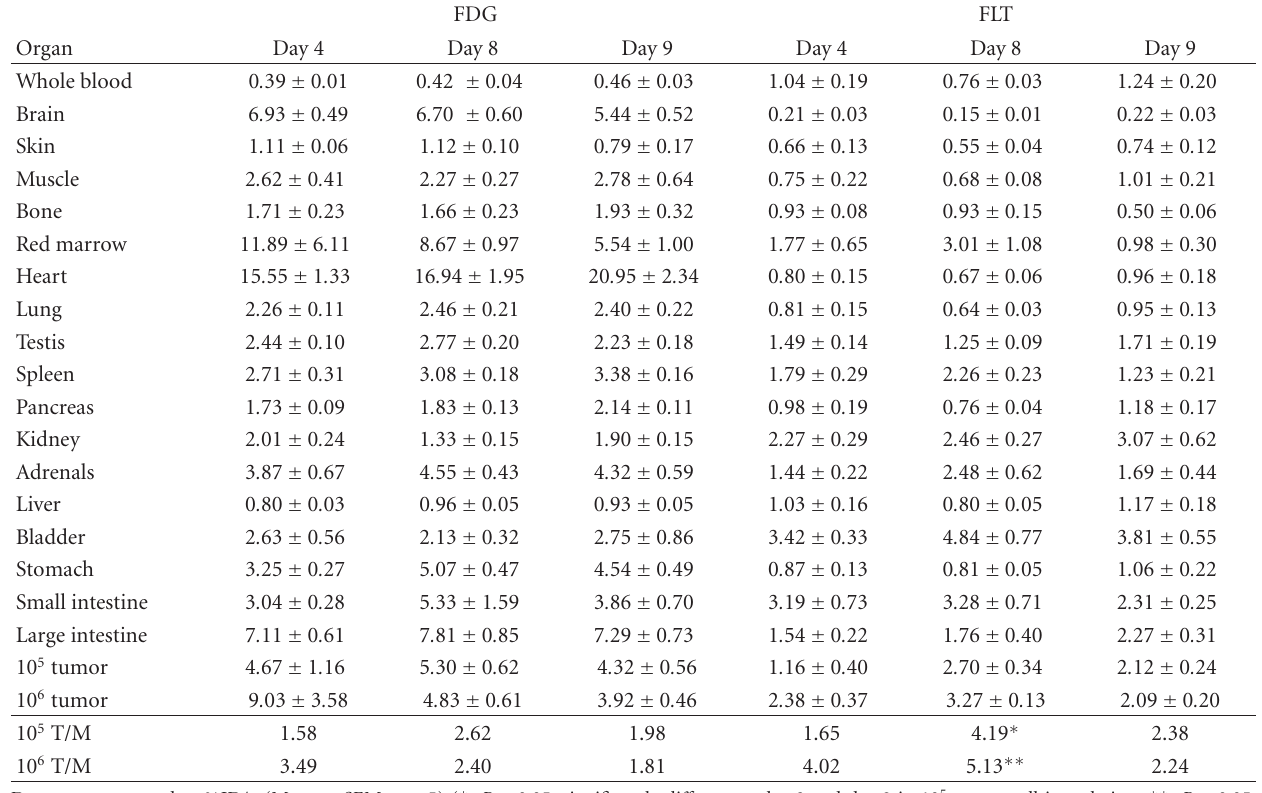
Table 1: Biodistribution of 18 F-FDG/ 18 F-FLT after i.v. injection.